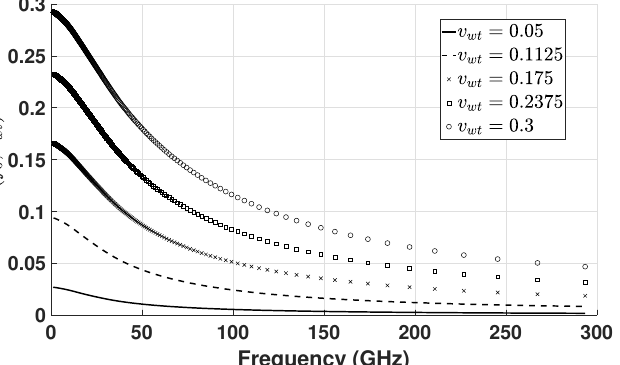
Figure 5. Radiowave reflectance as a function of frequency between 0.2–300 GHz and v wt between 0.05 and